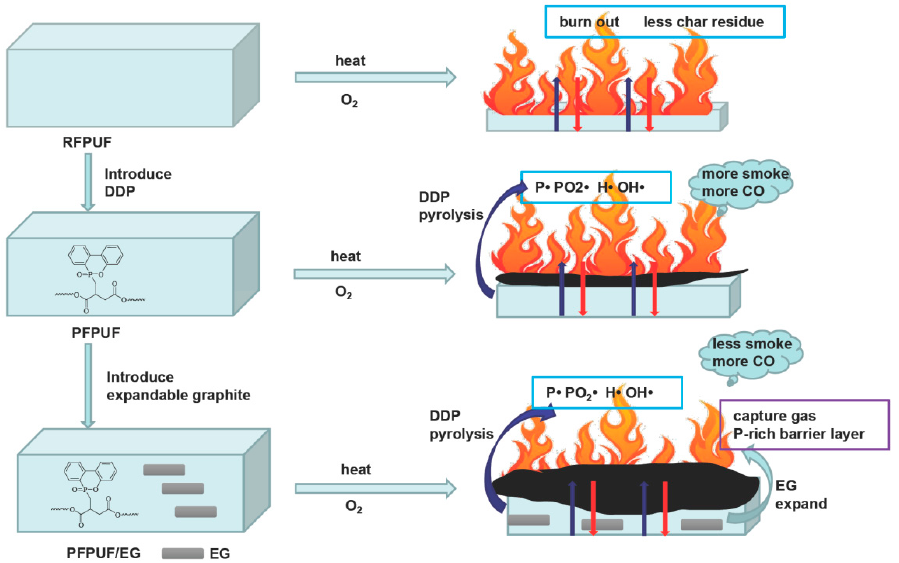
Figure 13. Schematic illustration of possible flame-retardant mechanism of phosphorus and EG in P-FPUFs.